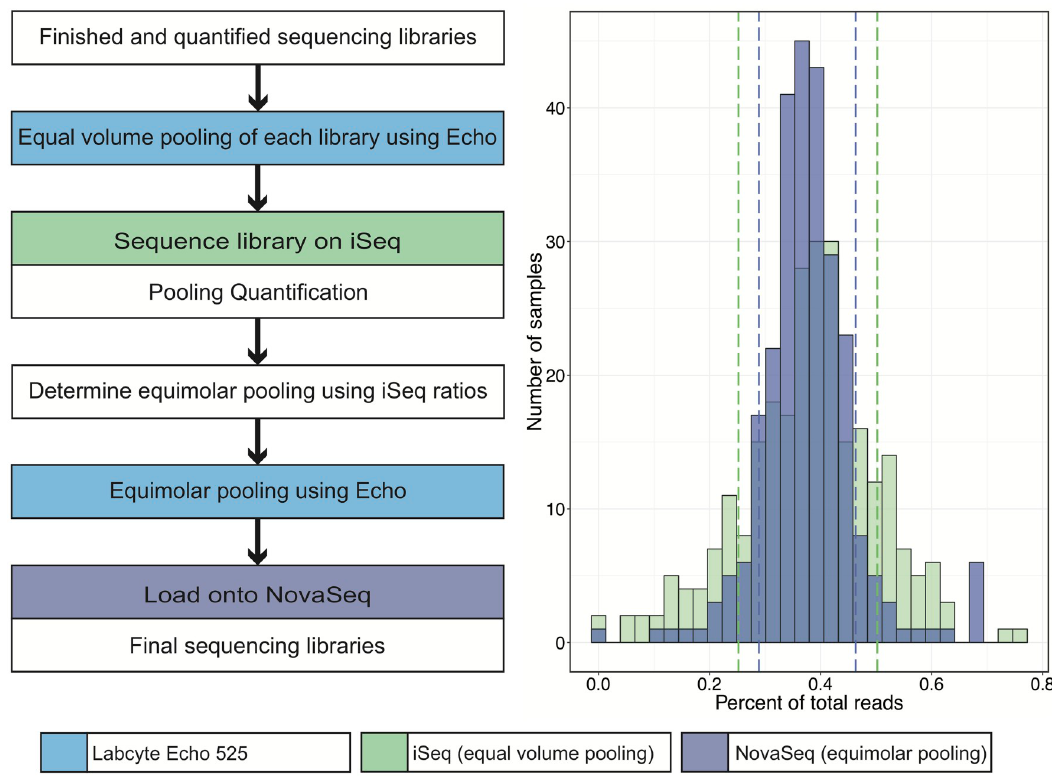
Fig 6. Pooling by iSeq correlates with pooling by NovaSeq. 265 libraries were pooled at equal volumes (0.5uL per library) using the Echo 525 and sequenced on the Illumina iSeq to a total combined depth of approximately 4.5 million reads (standard deviation indicated by green dashed lines). Resultant reads were assigned to each barcoded library to calculate the percent of total reads occupied by each sample. These ratios were used to re-pool each library in appropriate volumes (ranging from 160nL to 3800nL) using the Echo 525 to achieve equal read representation across all 265 samples. Libraries pooled at equal volumes and sequenced on the iSeq occupied a mean of 0.378% ± 0.125% of total sequencing reads (standard deviation indicated by purple dashed lines). Re- pooled based on iSeq ratios, libraries sequenced on the Illumina NovaSeq demonstrated a significantly tighter standard deviation ( F test p < 0.001), with each library occupying a mean of 0.376% ± 0.087% of total sequencing